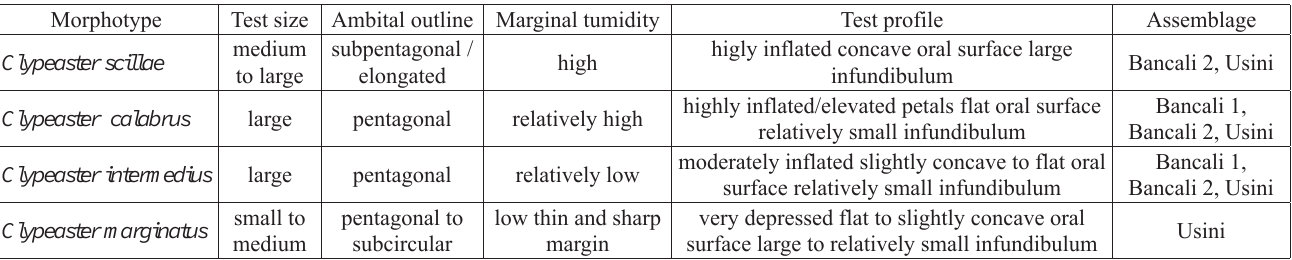
Table 1. Major test features of the four Clypeaster morphotypes recognized within the echinoid assemblages from early Miocene sections at Bancali and Usini, Sardinia, Italy.